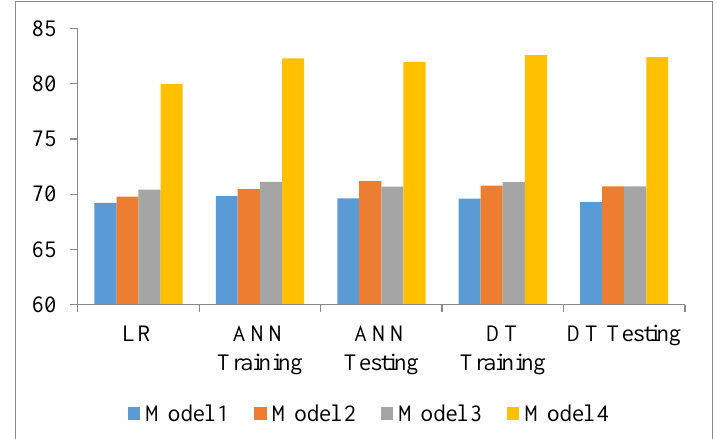
Figure 6. Comparison of overall accuracy of Logistic Regression, Artificial Neural Networks and Decision Tree models